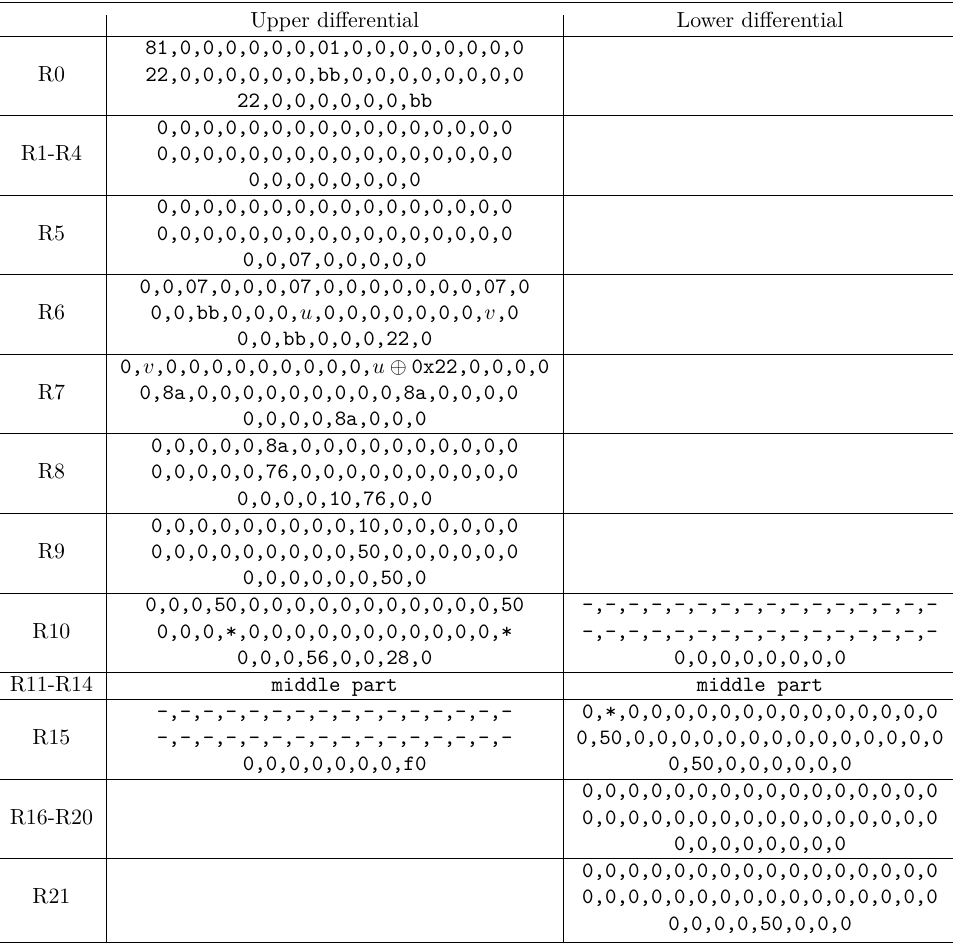
Table 19: The differentials of the 22-round distinguisher for SKINNY-128-384 , where R10 to R15 denote r = 6-round middle part, u satisfies DDT[ 0x07 ][ u ] > 0 and DDT[ u m